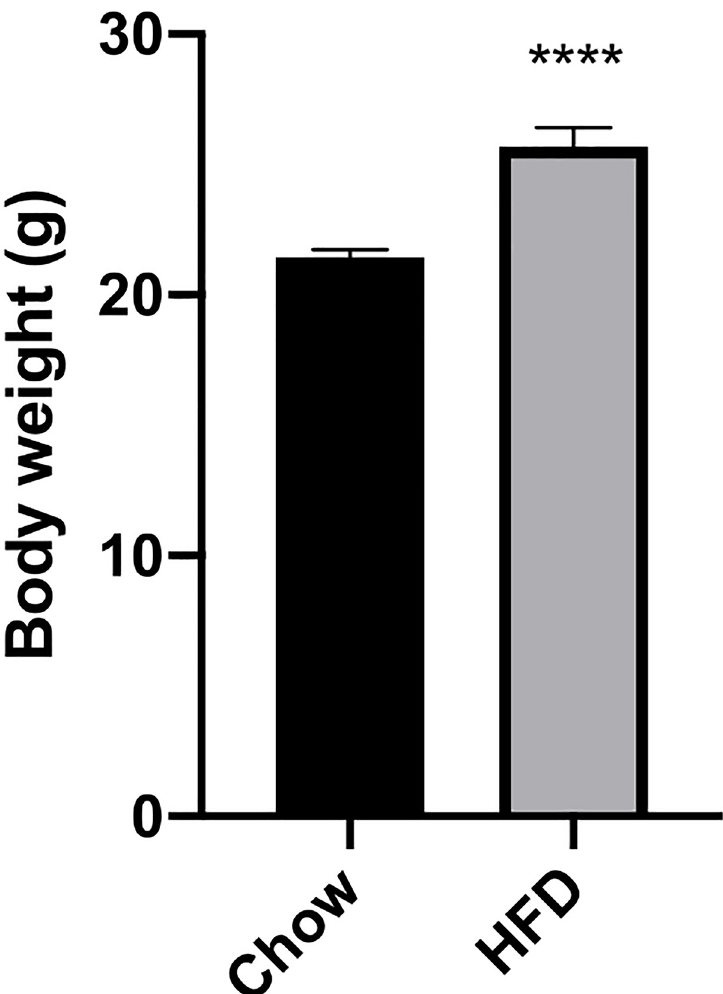
Fig 1. Maternal body weight at the commencement of breeding. Pre-breeding body weight of mothers. Results expressed as mean ± SEM, n = 13–20. ���� p < 0.0001.